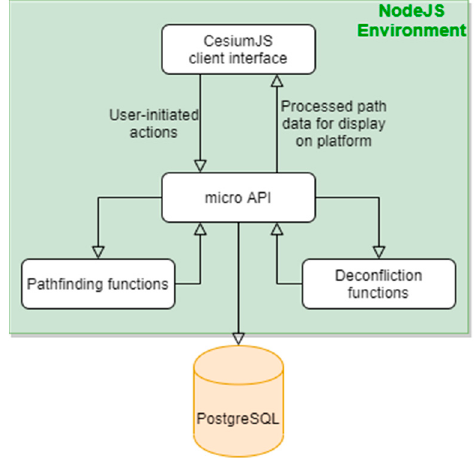
Figure 18. Schematic overview of Simulation components.